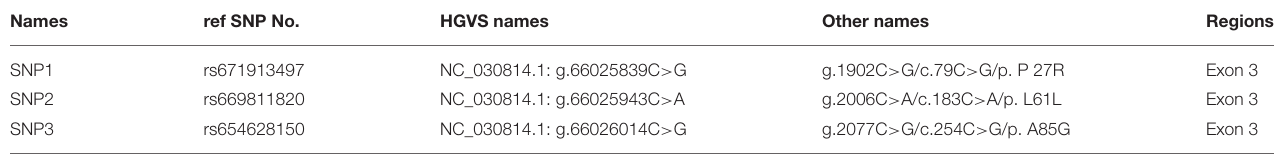
TABLE 1 | Name information of SNPs within the goat GDF9 gene.